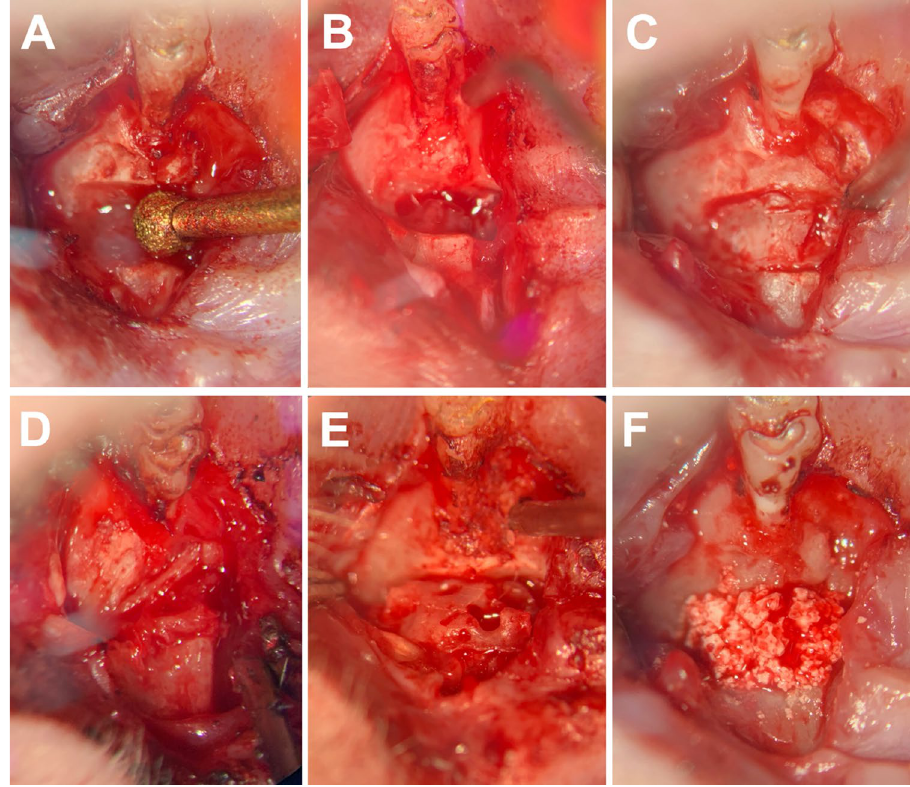
Figure 2. View of the operative situs of the left maxilla in supine position (magnification × 10): first molar above, mouth tip below: ( A ) artificial alveolar cleft creation using an ultrasonic device; ( B ) alveolar cleft with intact mucosa to the maxillary sinus and nasal passage; and ( C ) artificial alveolar cleft filled with bone wax. Re-entry and cleft repair were performed with ( D ) autograft from the ischial tuberosity of the hip, ( E ) human xenograft, or ( F ) β-TCP/HA bone substitute material.